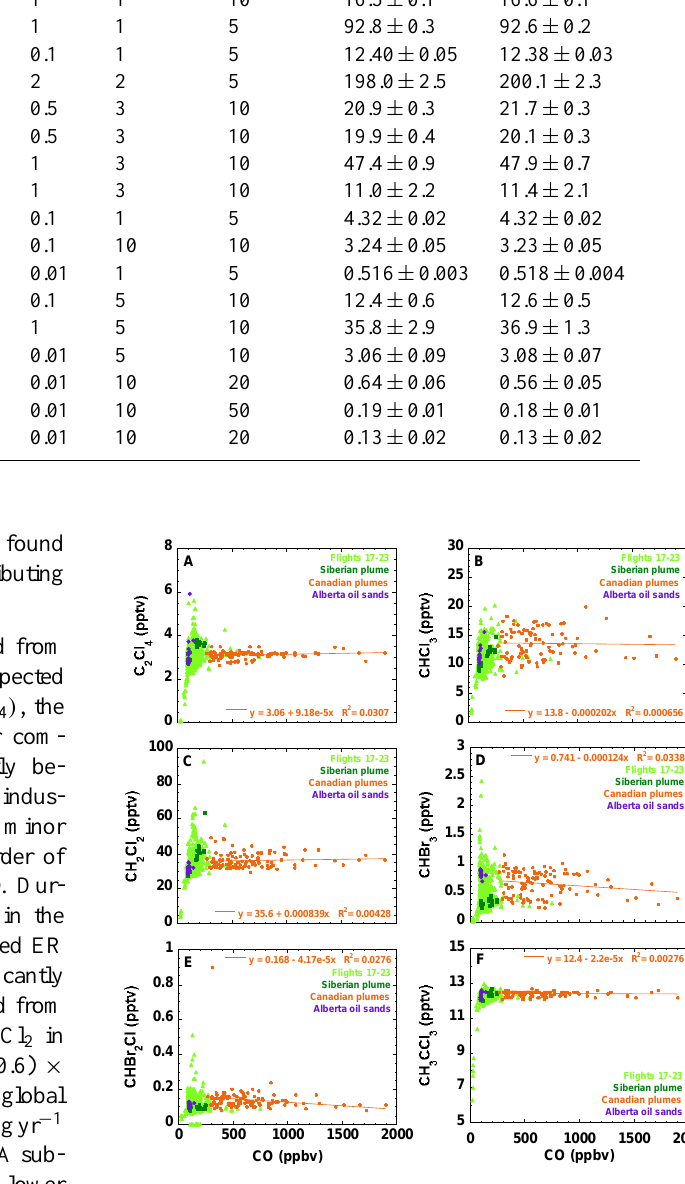
Figure 13. As in Figure 4 but for selected halocarbons that were not released from the fires. Fig. 13. As in Fig. 4 but for selected halocarbons that were not released from the